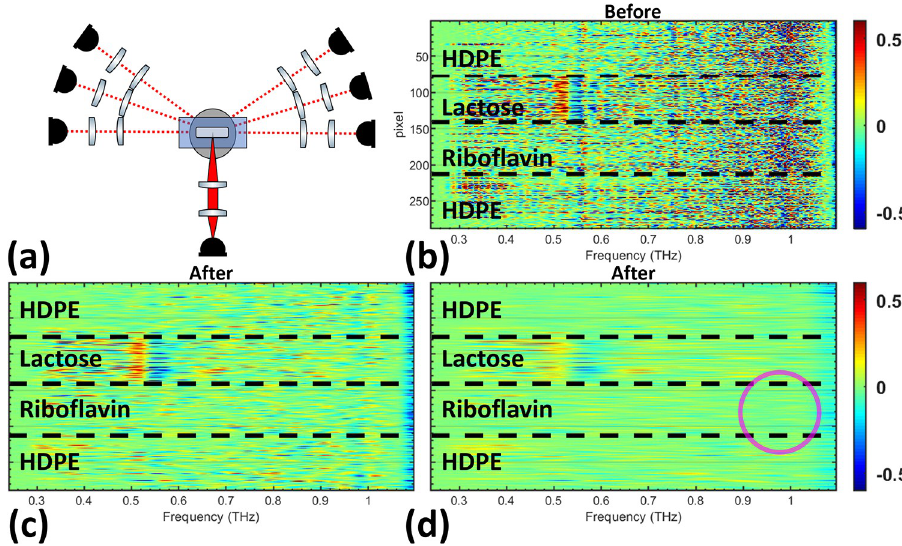
. (a) The optical configuration used in Fig 11 ( θ ( ± 3 to ± 5)